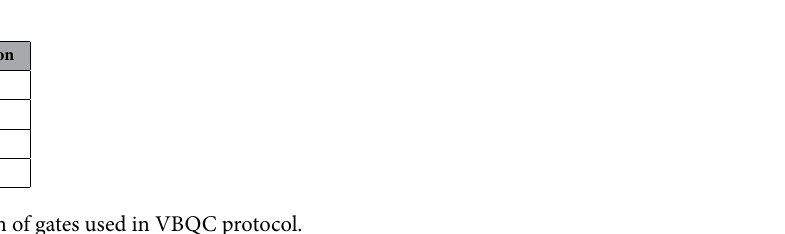
Table 3. Time duration of gates used in VBQC